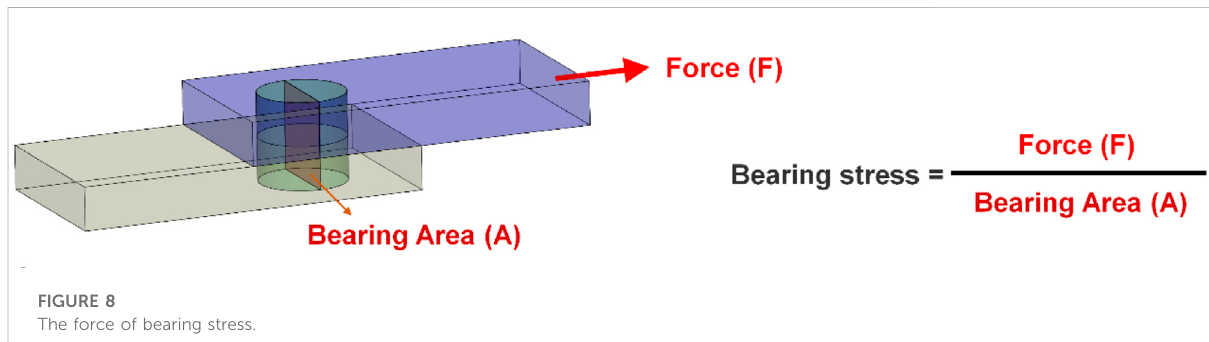
FIGURE 8 The force of bearing